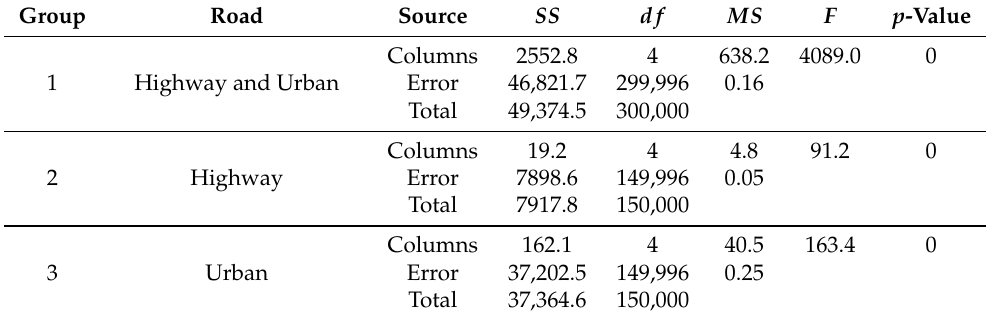
Table 7. ANOVA table for normalized energy divided into road groups and roughness